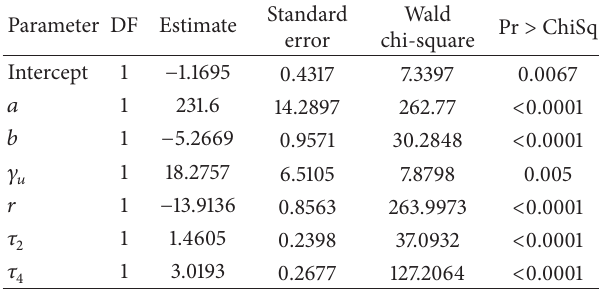
Table 5: Testing global null hypothesis.